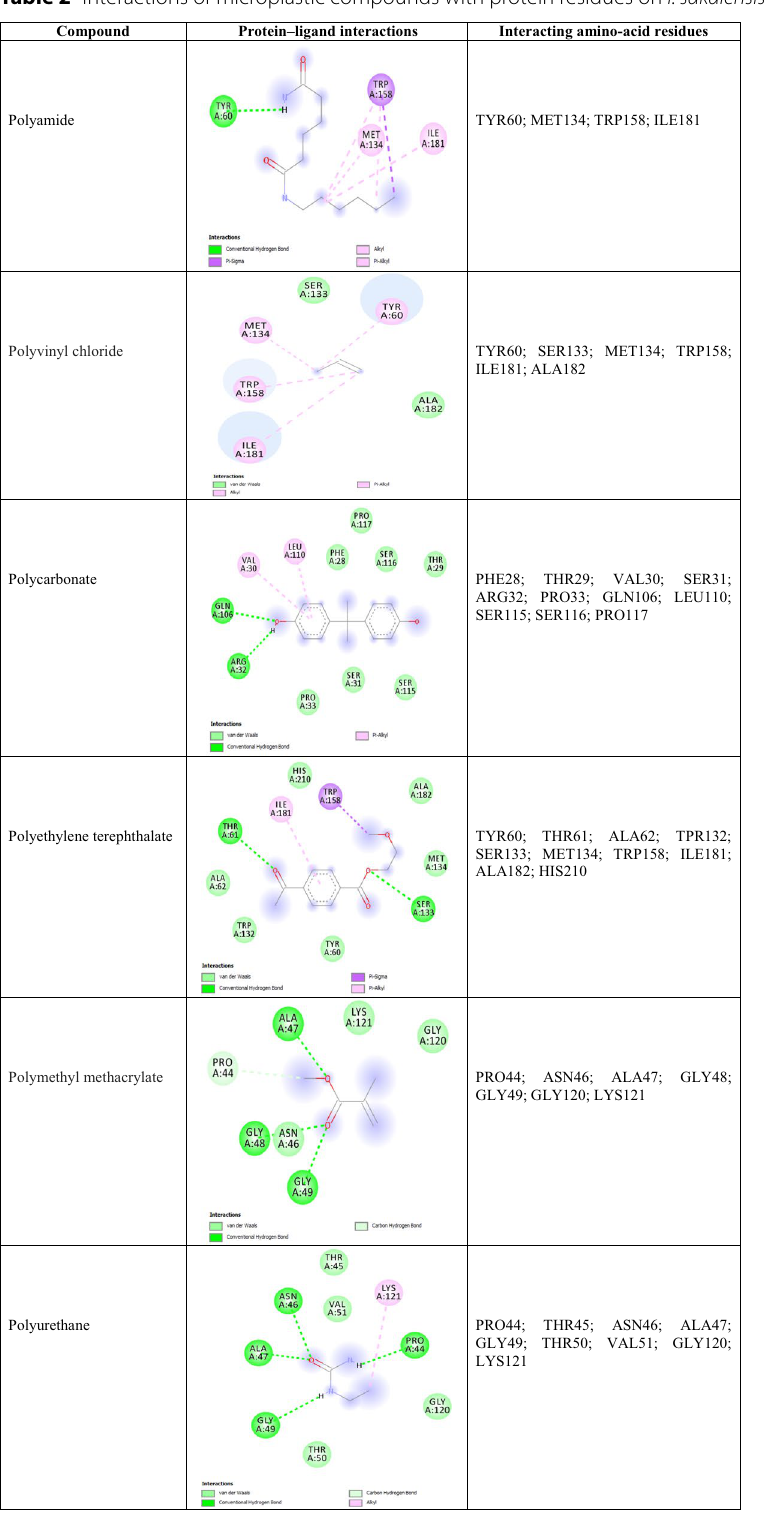
Table 2 Interactions of microplastic compounds with protein residues on I. sakaiensis